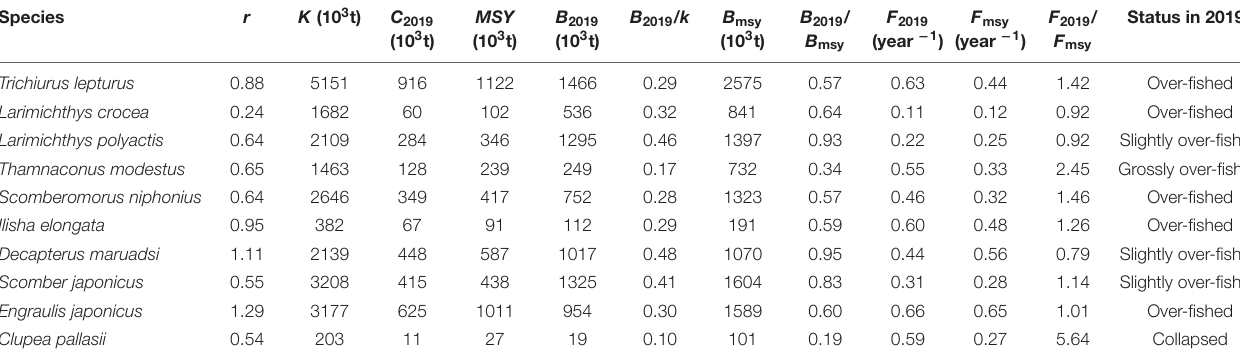
TABLE 2 | Model outputs of reference points for fish management.